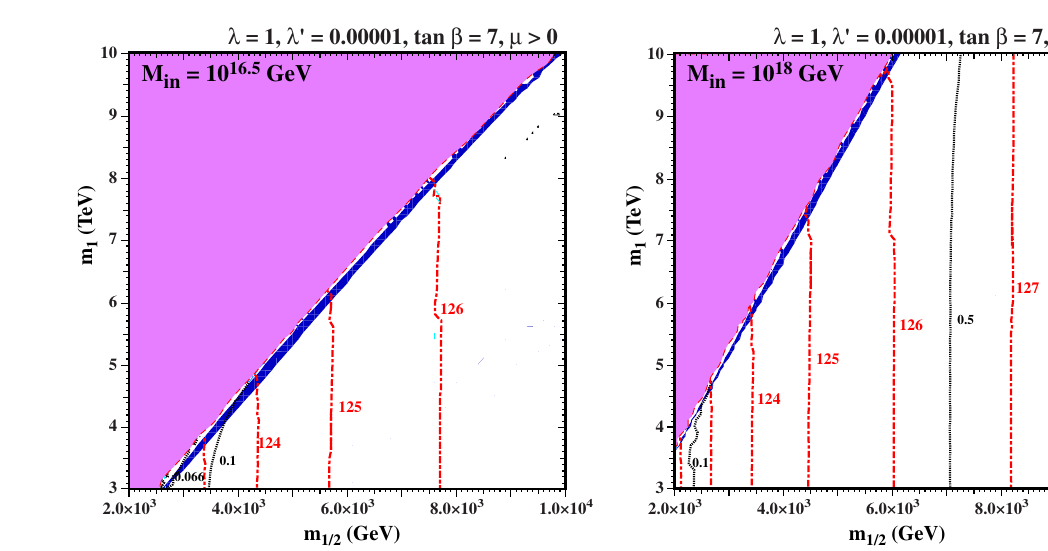
Fig. 4 Examples of ( m 1 / 2 , m 1 ) planes for M in = 10 16 . 5 ( left ) and 10 18 GeV ( right ) when both Higgs 5-plets are twisted. In both cases the modular weights are α t , b = 1, α λ = 2, α λ (cid:2) = 0, β H = 2 and β (cid:3) = 0, corresponding to A 0 = B 0 = 0, and we assume tan β = 7, λ = 1 and